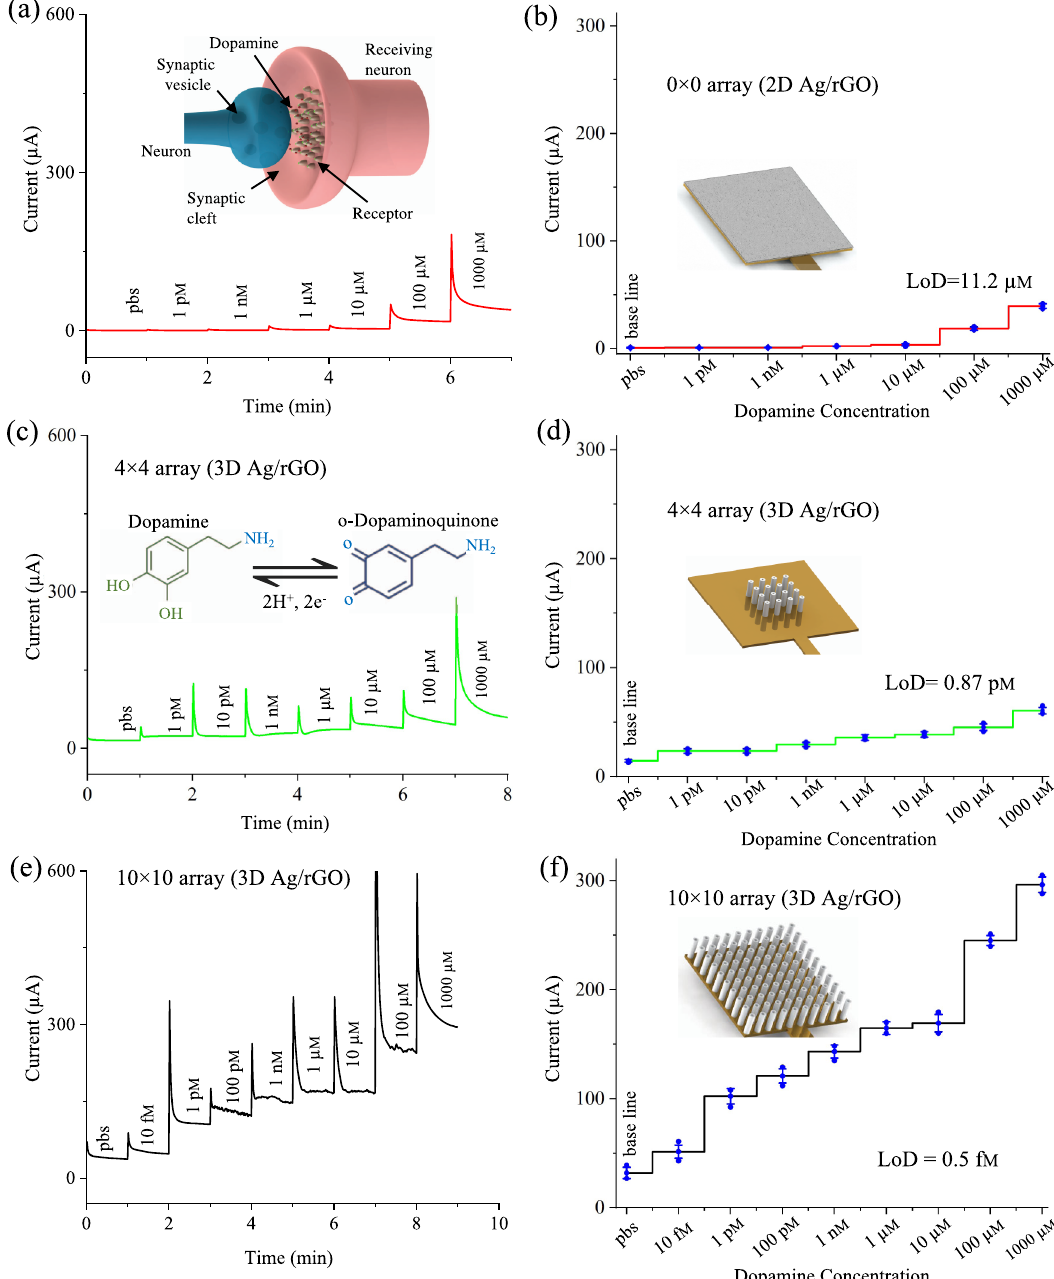
Fig. 4 Sensing of dopamine molecules. a Chronoamperometric sensing curves for 2D Ag/rGO (0 × 0 array) sensor. The dopamine (dopamine hydrochloride) concentration is diluted from 1 p M to 1000 μ M in pbs solution (pH 7.4) containing 1 m M concentration of ferro/ferricyanide. The measurements were conducted without any enzyme at a fi xed sensing potential of − 0.1 V for 1 min. Inset of ( a ) shows a schematic of dopamine molecules released from pre-synaptic neuron to target post-synaptic neuron. b Saturation currents of 2D Ag/rGO sensor plotted against varying dopamine concentrations. c , e Chronoamperometric sensing of multi-length-scale 3D Ag/rGO (4 × 4 array) and 3D Ag/rGO (10 × 10 array) sensors, respectively, at the same condition as that performed for 2D Ag/rGO sensor. A low concentration (10 f M ) of dopamine was tested in addition to 1 p M to 1000 μ M for 3D Ag/rGO (10 × 10 array) sensor. Inset of ( c ) shows the biochemical oxidation/reduction reaction of dopamine. d , f Current responses with varying dopamine concentration for multi-scale 3D Ag/rGO (4 × 4 array) and 3D Ag/rGO (10 × 10 array) con fi gurations, respectively. The detection time for all the results in this fi gure are within 60 seconds. Error bars in Fig. 4b, d, f are the standard deviation of three repeated measurements ( n = 3 biologically independent experiments). Error bars, mean ±